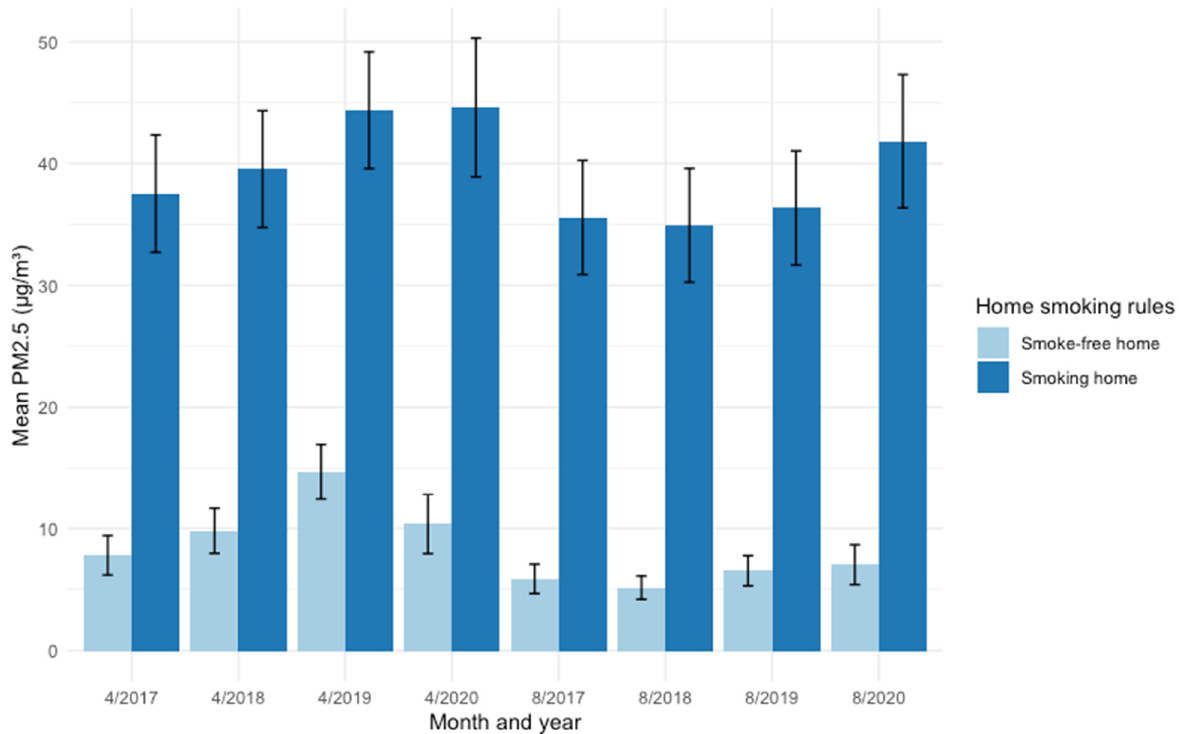
Figure 3. Mean PM 2.5 exposure by home smoking status in each month. Error bars represent standard deviation.